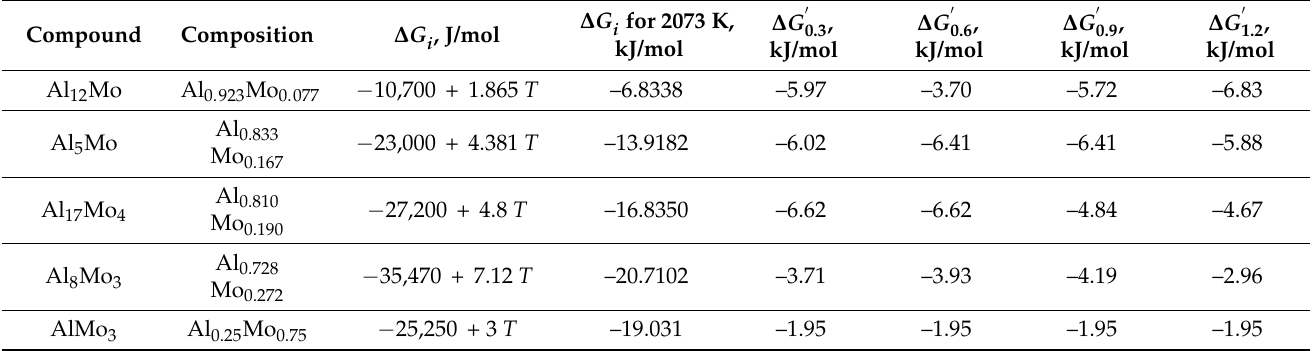
Table 7 contains the effective Gibbs free energy changes calculated for all Al/Mo phases. Table 7. Effective Gibbs free energy changes calculated for all Al/Mo phases in AA5154/Mo at 2073